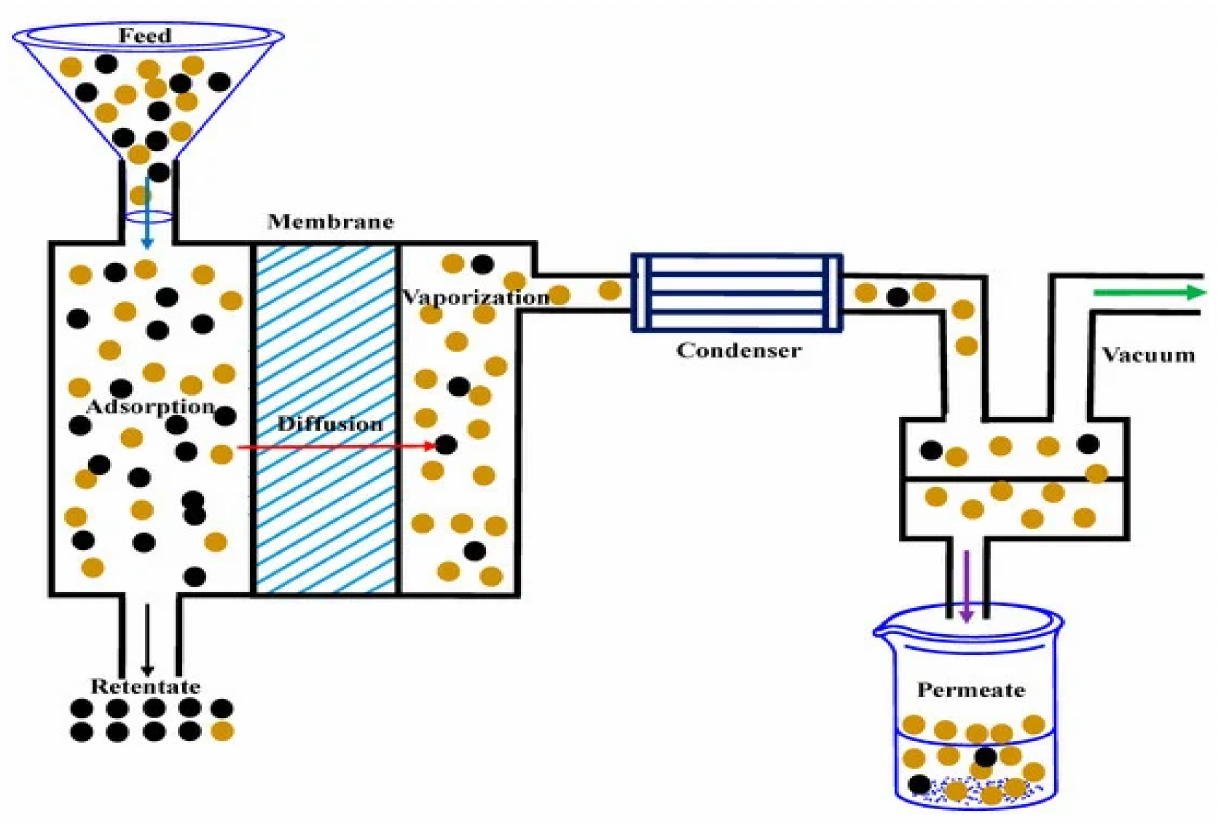
Figure 15. Schematic representation of the basic purification setup with a membrane [Reprinted with permission from ref. [196], Roy, S.; Singha, N.R. Polymeric Nanocomposite Membranes for Next Generation Pervaporation Process: Strategies, Challenges and Future Prospects. Membranes 2017 , 7 ,53. https://doi.org/10.3390/membranes7030053], Copyright ©